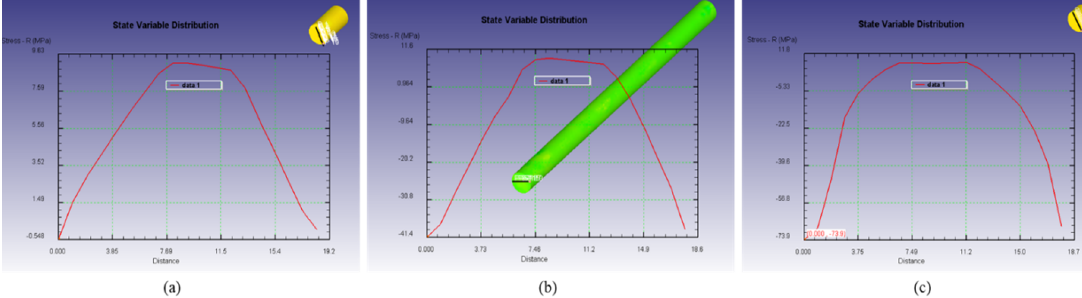
Figure 9. The predicted residual stresses in the radial direction for the 25% swaged samples ( a ) at 0.7 m/min feed rate, ( b ) at 1.25 m/min feed rate and ( c ) at 2 m/min feed rate.